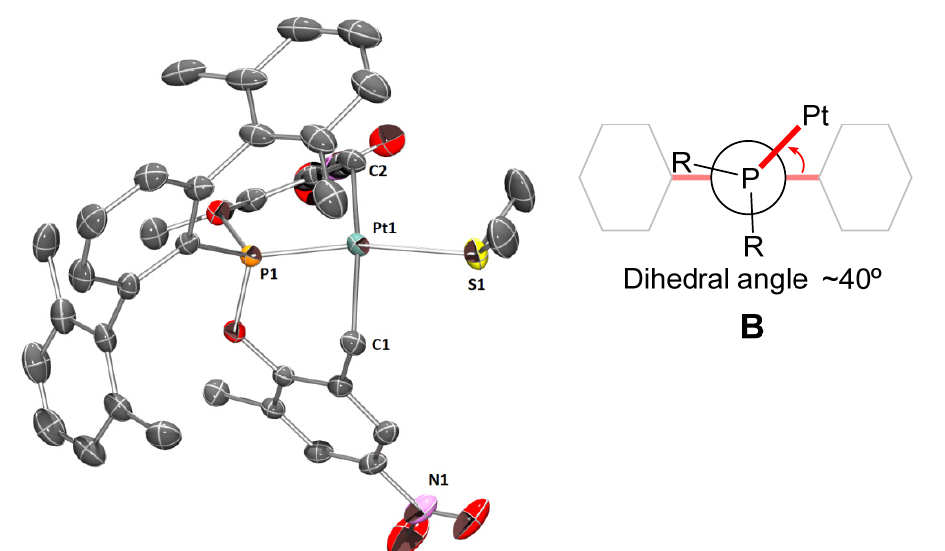
Figure 5. ORTEP view of the X-ray molecular structure of complex 3 ∙ SMe 2 , with ellipsoids at the 50% probability level and H atoms omitted for clarity ( left ); schematic view of the B conformation adopted by the ligand PAr Xyl 2 (OPh NO 2 ,Me ) 2 ( right ) [17,25]. Selected bond distances (Å) and angles (°): Pt1-P1 2.1526(9), Pt1-C1 2.155(3), Pt1-C2 2.120(3), Pt1-S1 2.339(1); P1-Pt1-C1 84.18(7); C1-Pt1-S1 86.74(8); S1-Pt1-C2 99.09(9); C2-Pt1-P1 89.23(8); C1-Pt1-C2 169(1).